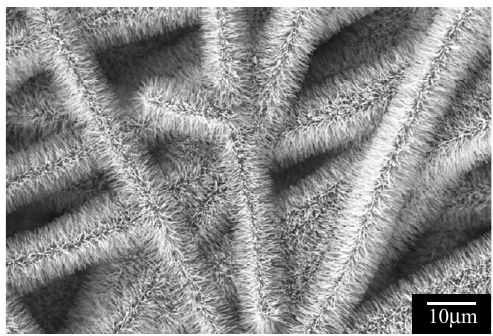
Figure 4. Scanning electron micrograph of zinc oxide nanowires densely grown on the surface of carbon nanofibrous membranes (Adapted from [17]).